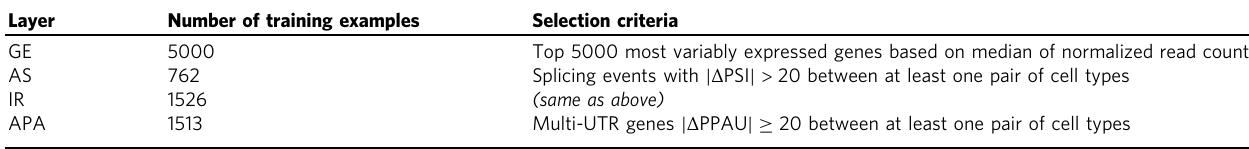
Table 1 Filtering criteria for each regulatory